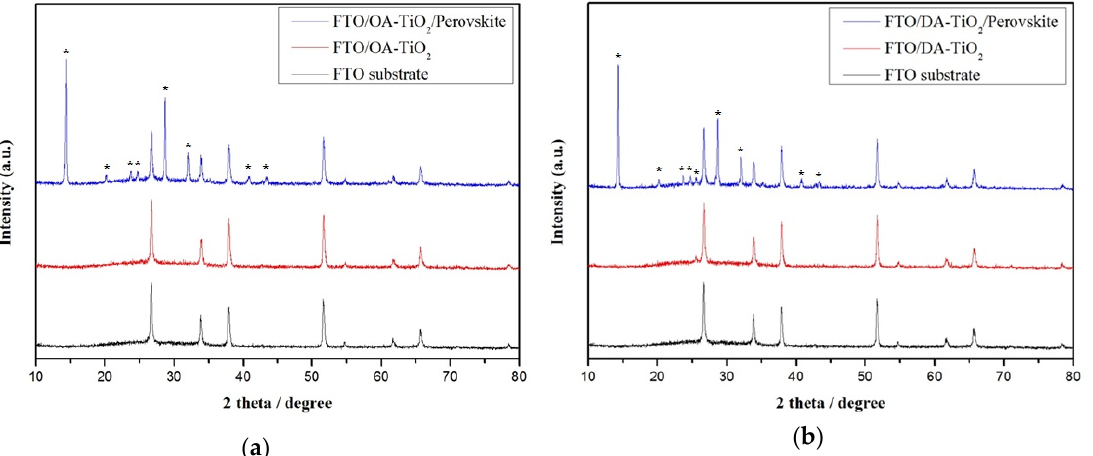
Figure 7. XRD results of ( a ) OC TiO 2 film and ( b ) DC TiO 2 film fabricated on fluorine ‐ doped tin oxide (FTO) substrate.